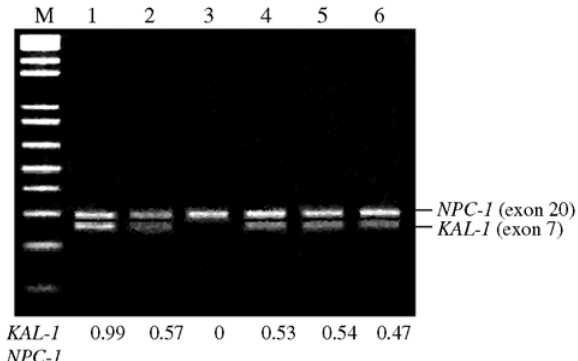
Figure 3 - Comparative duplex PCR for identification of carrier females. Lanes:1-controlfemale;2-controlmale;3-5-individualsfromfamily1, respectively, III-4 (affected male), II-11 and III-17 (mothers of patients III-12 and IV-6); and 6 - individual I-2 from family 2 (mother of patients II-4 and II-6). M - molecular weight marker. Values for the KAL-1 / NPCI ratio are given below each